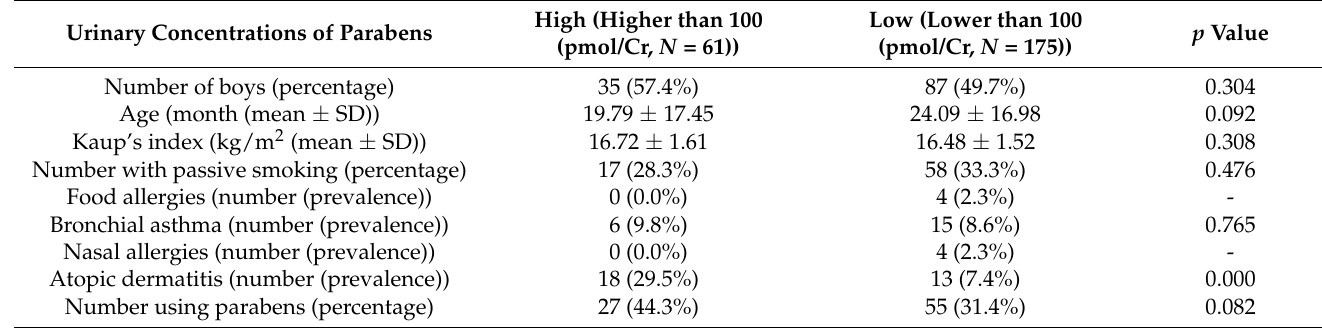
Table 4. Comparisons of prevalence of allergic diseases between children with high and low urinary concentrations of parabens.